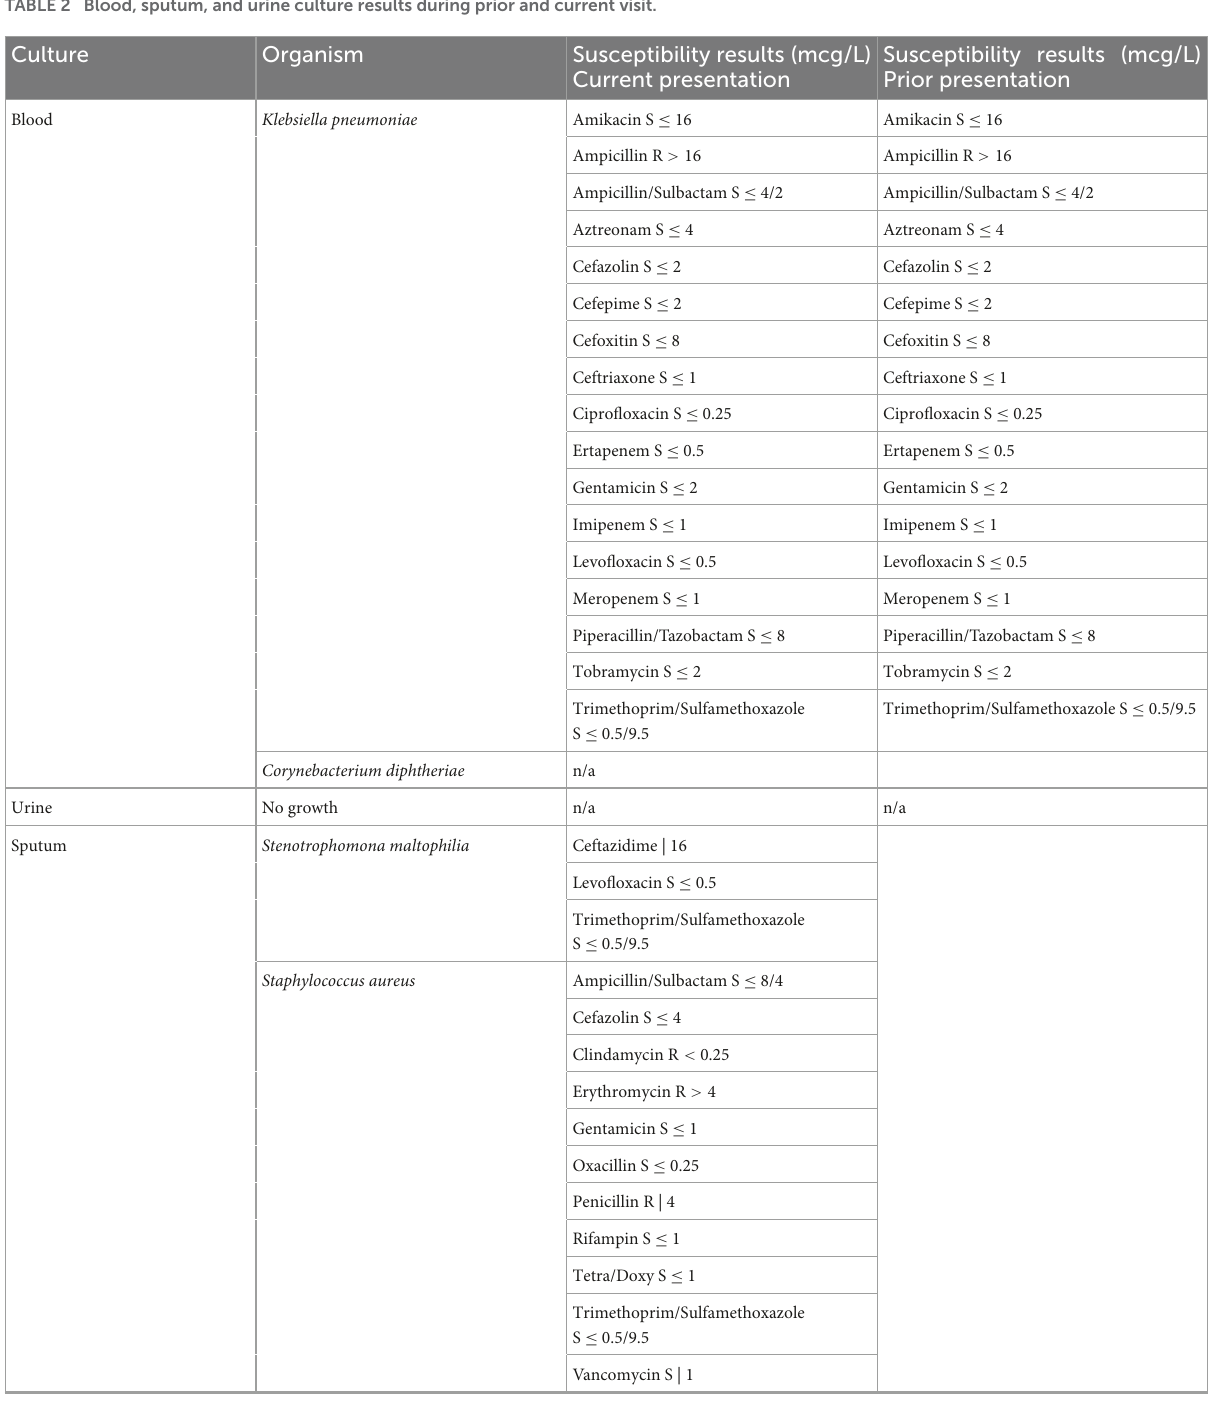
TABLE 2 Blood, sputum, and urine culture results during prior and current